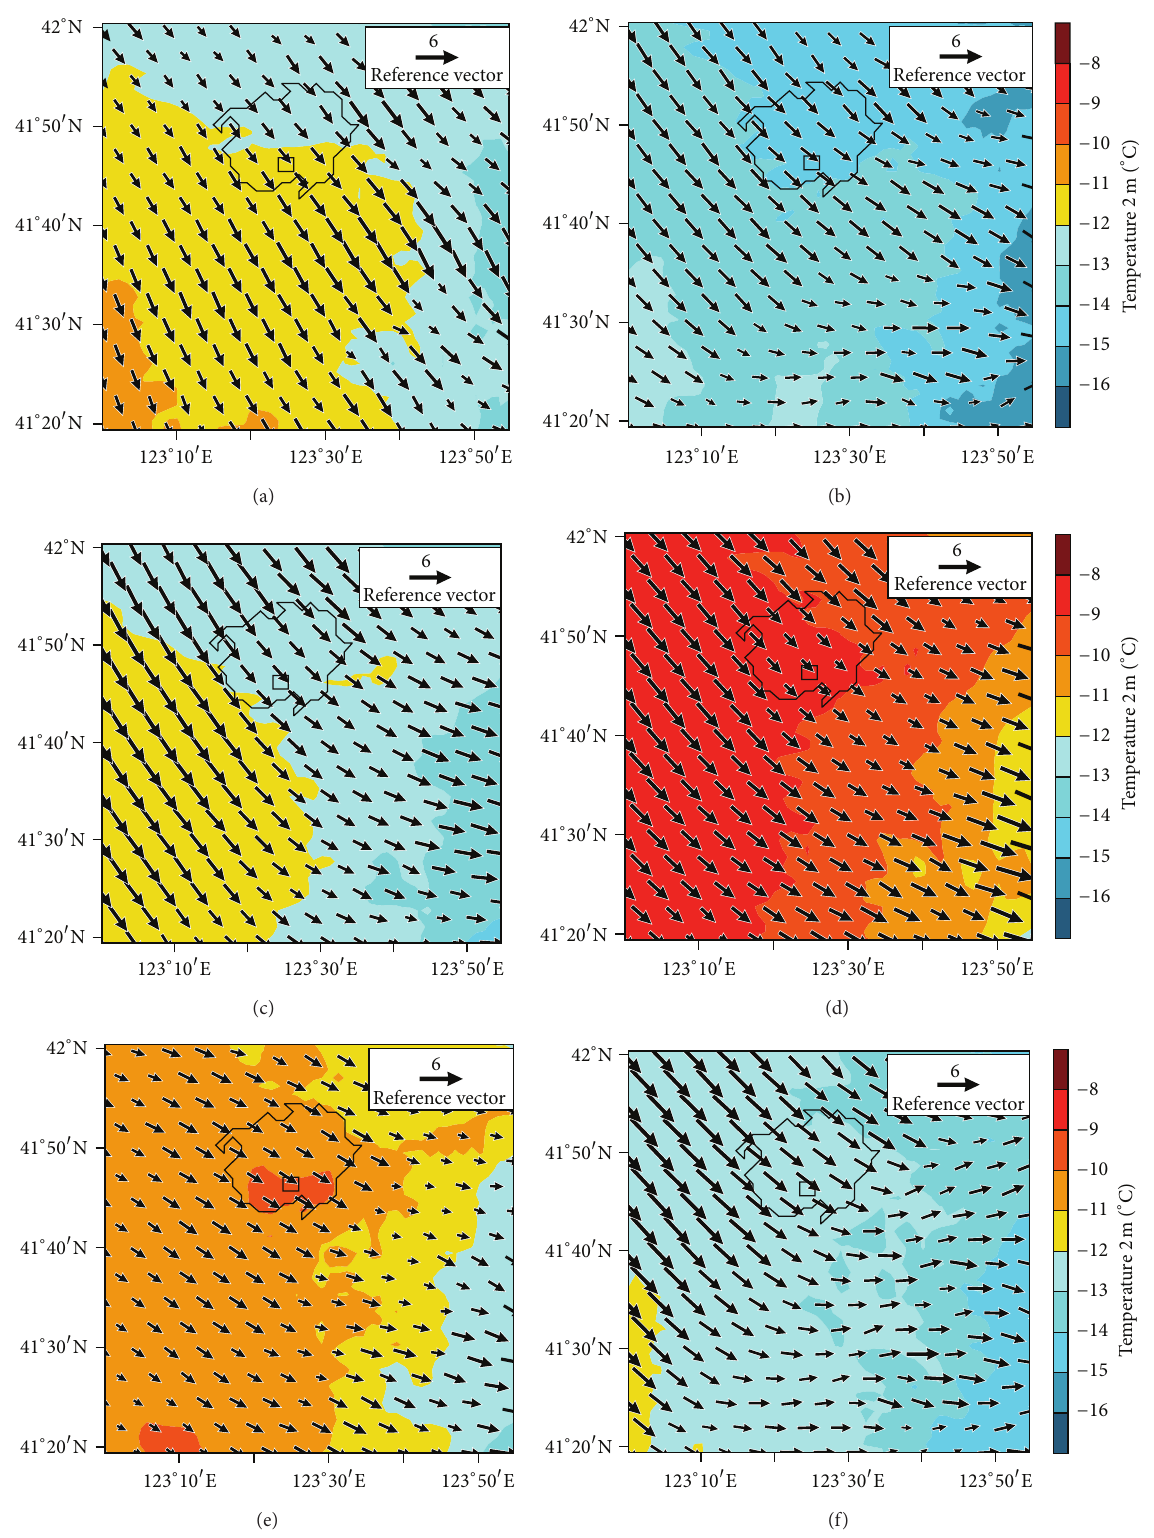
Figure 5: The 10-m wind vector fields and 2-m temperature fields of Shenyang on 16th of February 2012: (a) 0200 LST; (b) 0600 LST; (c) 1000 LST; (d) 1400 LST; (e) 1800 LST; (f) 2200 LST. The location of the CFD model domain is indicated by the square, and the area of Shenyang city is indicated by black solid